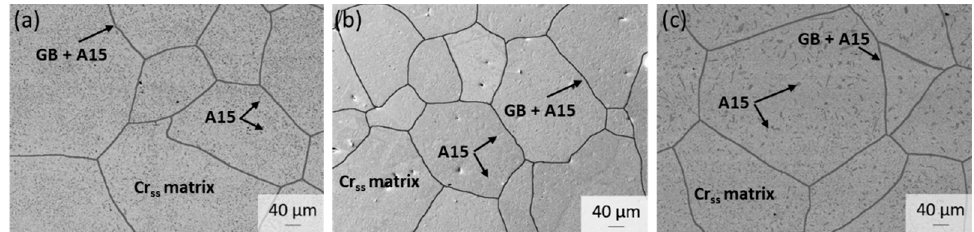
Figure 1. Microstructures of ( a ) Cr 91 Si 9 , ( b ) Cr 91 Si 7 Ge 2 , and ( c ) Cr 91 Si 7 Mo 2 alloy after annealing for 100 h at 1200 °C.